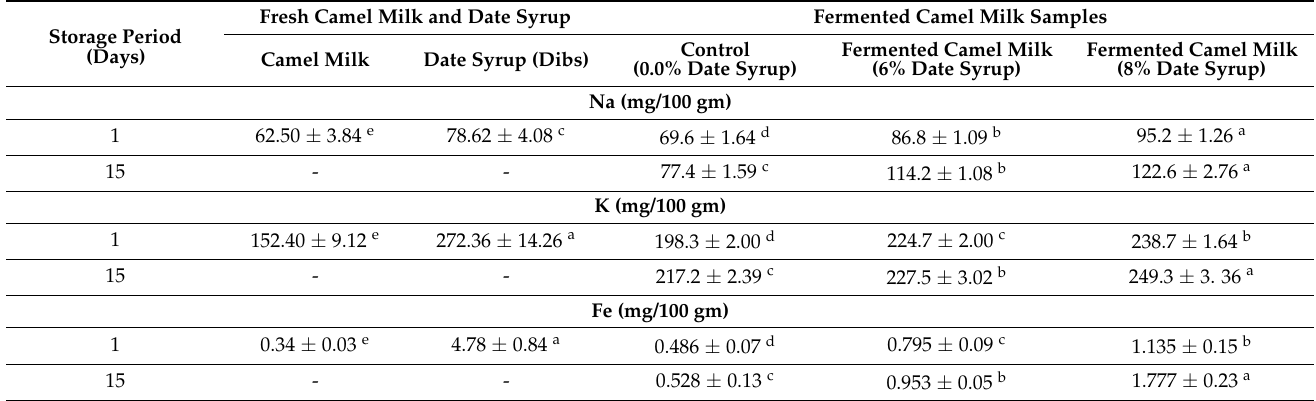
Table 4. Na, K, and Fe content of the camel milk (control) and fermented camel milk with date syrup during the cooled storage